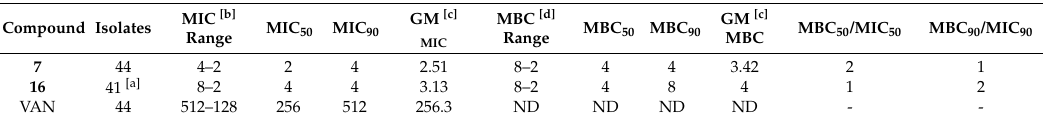
Table 3. Summary of antibacterial activity of compounds 7 , 16 and vancomycin against MDR Enterococcus sp. MIC and MBC ( μ g/mL).